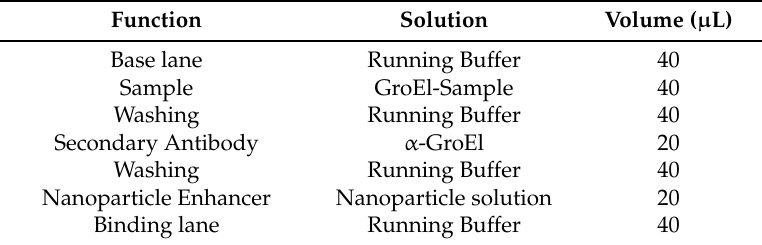
Table 1. Description of the assay procedure. The single steps will be performed automatically by the microfluidic cartridge and monitored by the integrated photonic sensor. Each step defines solutions and volumes of the reagents to be loaded into the microfluidic